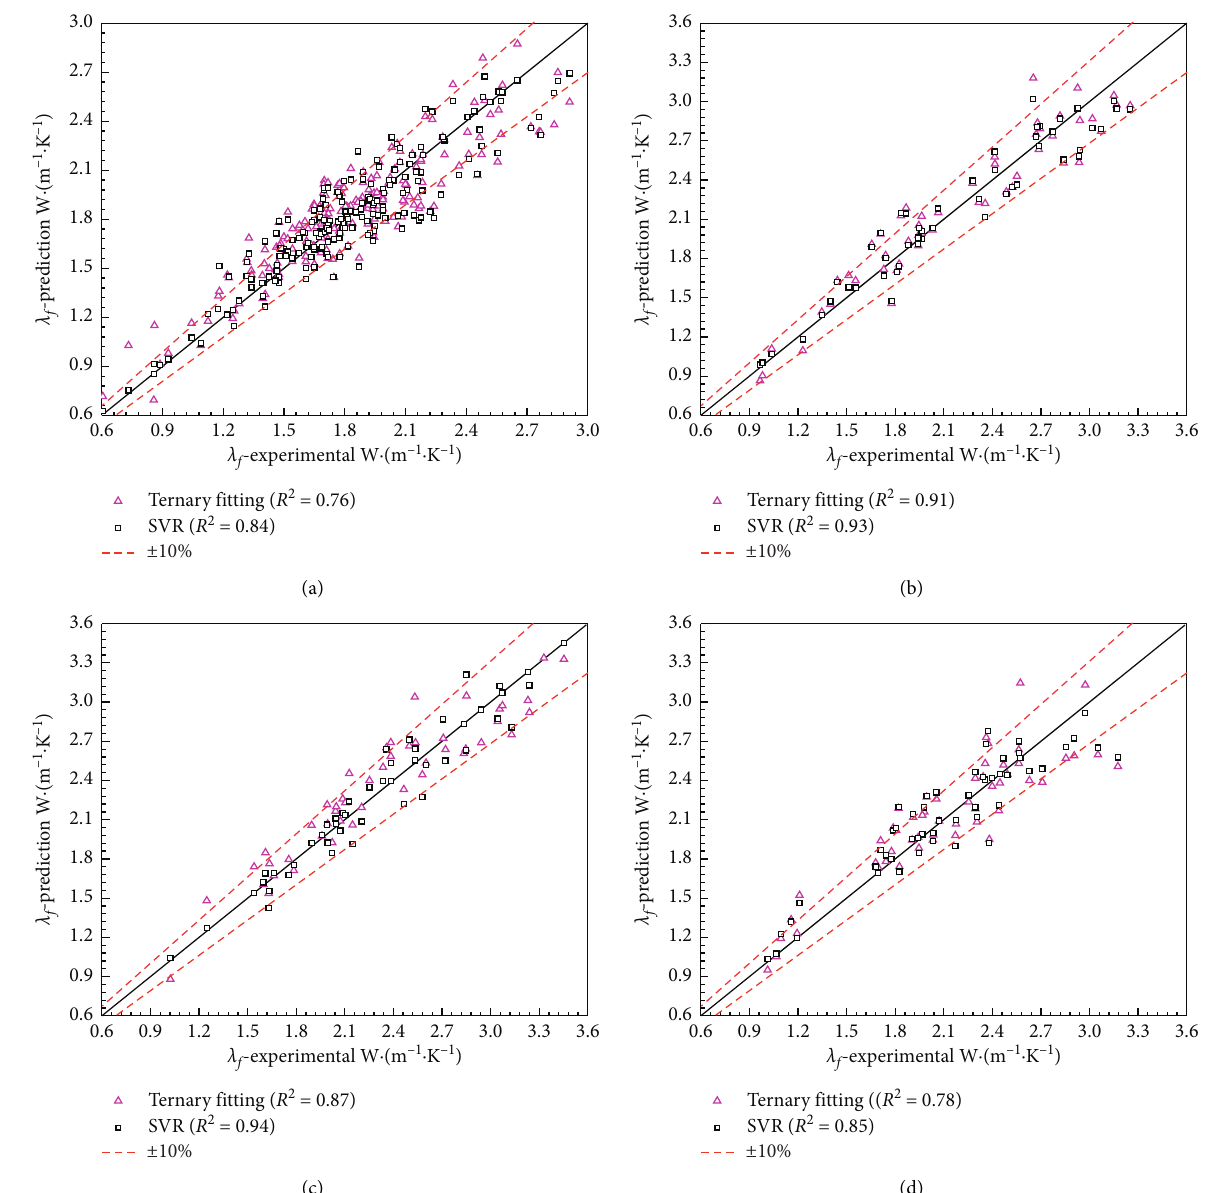
Figure 8: Comparison of predictive results of the SVR model and ternary fitting model. (a) Slit. (b) Fine sand. (c) Boulder. (d)